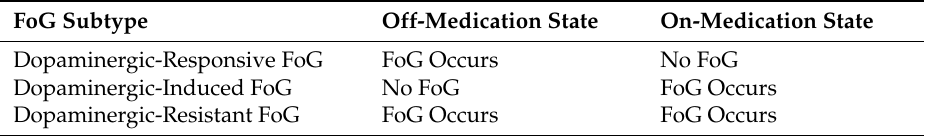
Table 1. Freezing of Gait (FoG) subtypes and response to dopaminergic medication. FoG